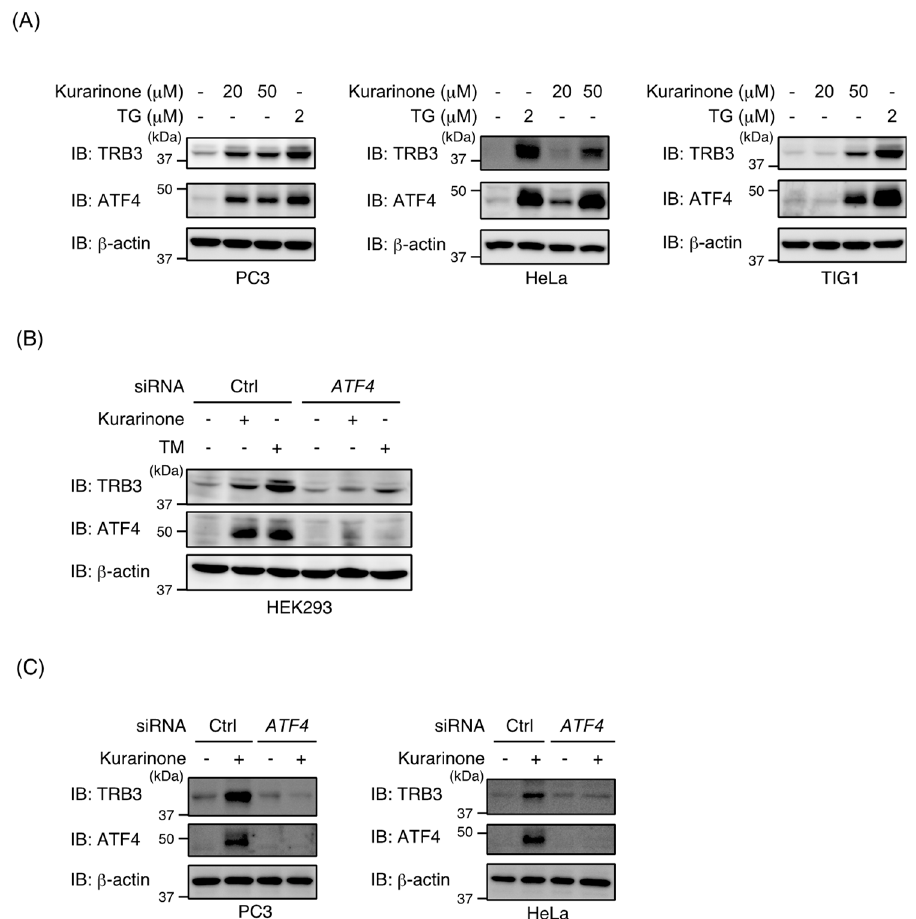
Figure 2. Kurarinone induces TRB3 expression in an ATF4-dependent manner. ( A ) PC3 cells, HeLa cells, and TIG1 cells were treated with the indicated doses of thapsigargin (TG) or kurarinone for 6 h. Cell lysates were immunoblotted with the indicated antibodies. ( B ) HEK293 cells were transiently transfected with the indicated siRNAs. After 48 h, cells were treated with 0.6 µ g / mL of TM or 50 µ M of kurarinone for 6 h. Cell lysates were immunoblotted with the indicated antibodies as in ( A ). ( C ) PC3 and HeLa cells were transiently transfected with the indicated siRNAs. After 48 h, cells were treated with 50 µ M of kurarinone for 6 h. Cell lysates were immunoblotted with the indicated antibodies as in ( A ). Ctrl,